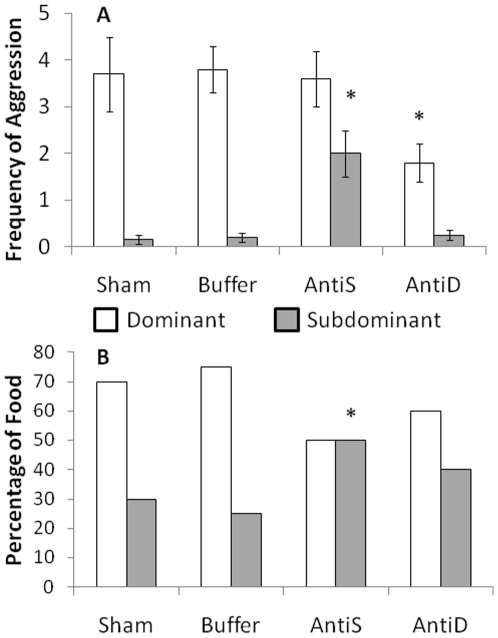
Impact of inactivation of ependymin in dominant and subdominant zebrafish.(A) The mean frequency (±SE) of aggressive attacks performed by the dominant and subdominant zebrafish in the sham control (Sham), subdominant injected with buffer (Buffer), subdominant injected with antisera (AntiS) and the dominant injected with antisera (AntiD) after treatment. The treatment was applied 6 hours before observation which relates to maximal inactivation of ependymin (19,20) when antiserum was applied. The subdominant injected with antisera (AntiS) showed a significant increase in aggressive attacks compared with its normal behaviour prior to treatment and when compared with the control groups (*P<0.001). The dominant injected with antisera (AntiB) exhibited a significant decrease in aggression (*P = 0.023). (B) The median percentage of food acquired by the dominant and subdominant zebrafish in the Sham Control (Sham), Subdominant injected with buffer (Buffer), subdominant injected with anti-sera (AntiS) and the dominant injected with antisera (AntiD) after treatment. Again the treatment was applied 6 hours before observation 3 where the subdominant injected with antisera (AntiS) obtained significantly more food compared with the control groups (*P = 0.021). Therefore, ependymin inactivation led to a significant increase in aggression and competitive ability in subdominant zebrafish. In contrast, ependymin inactivation led to a decrease in aggression in dominant zebrafish.